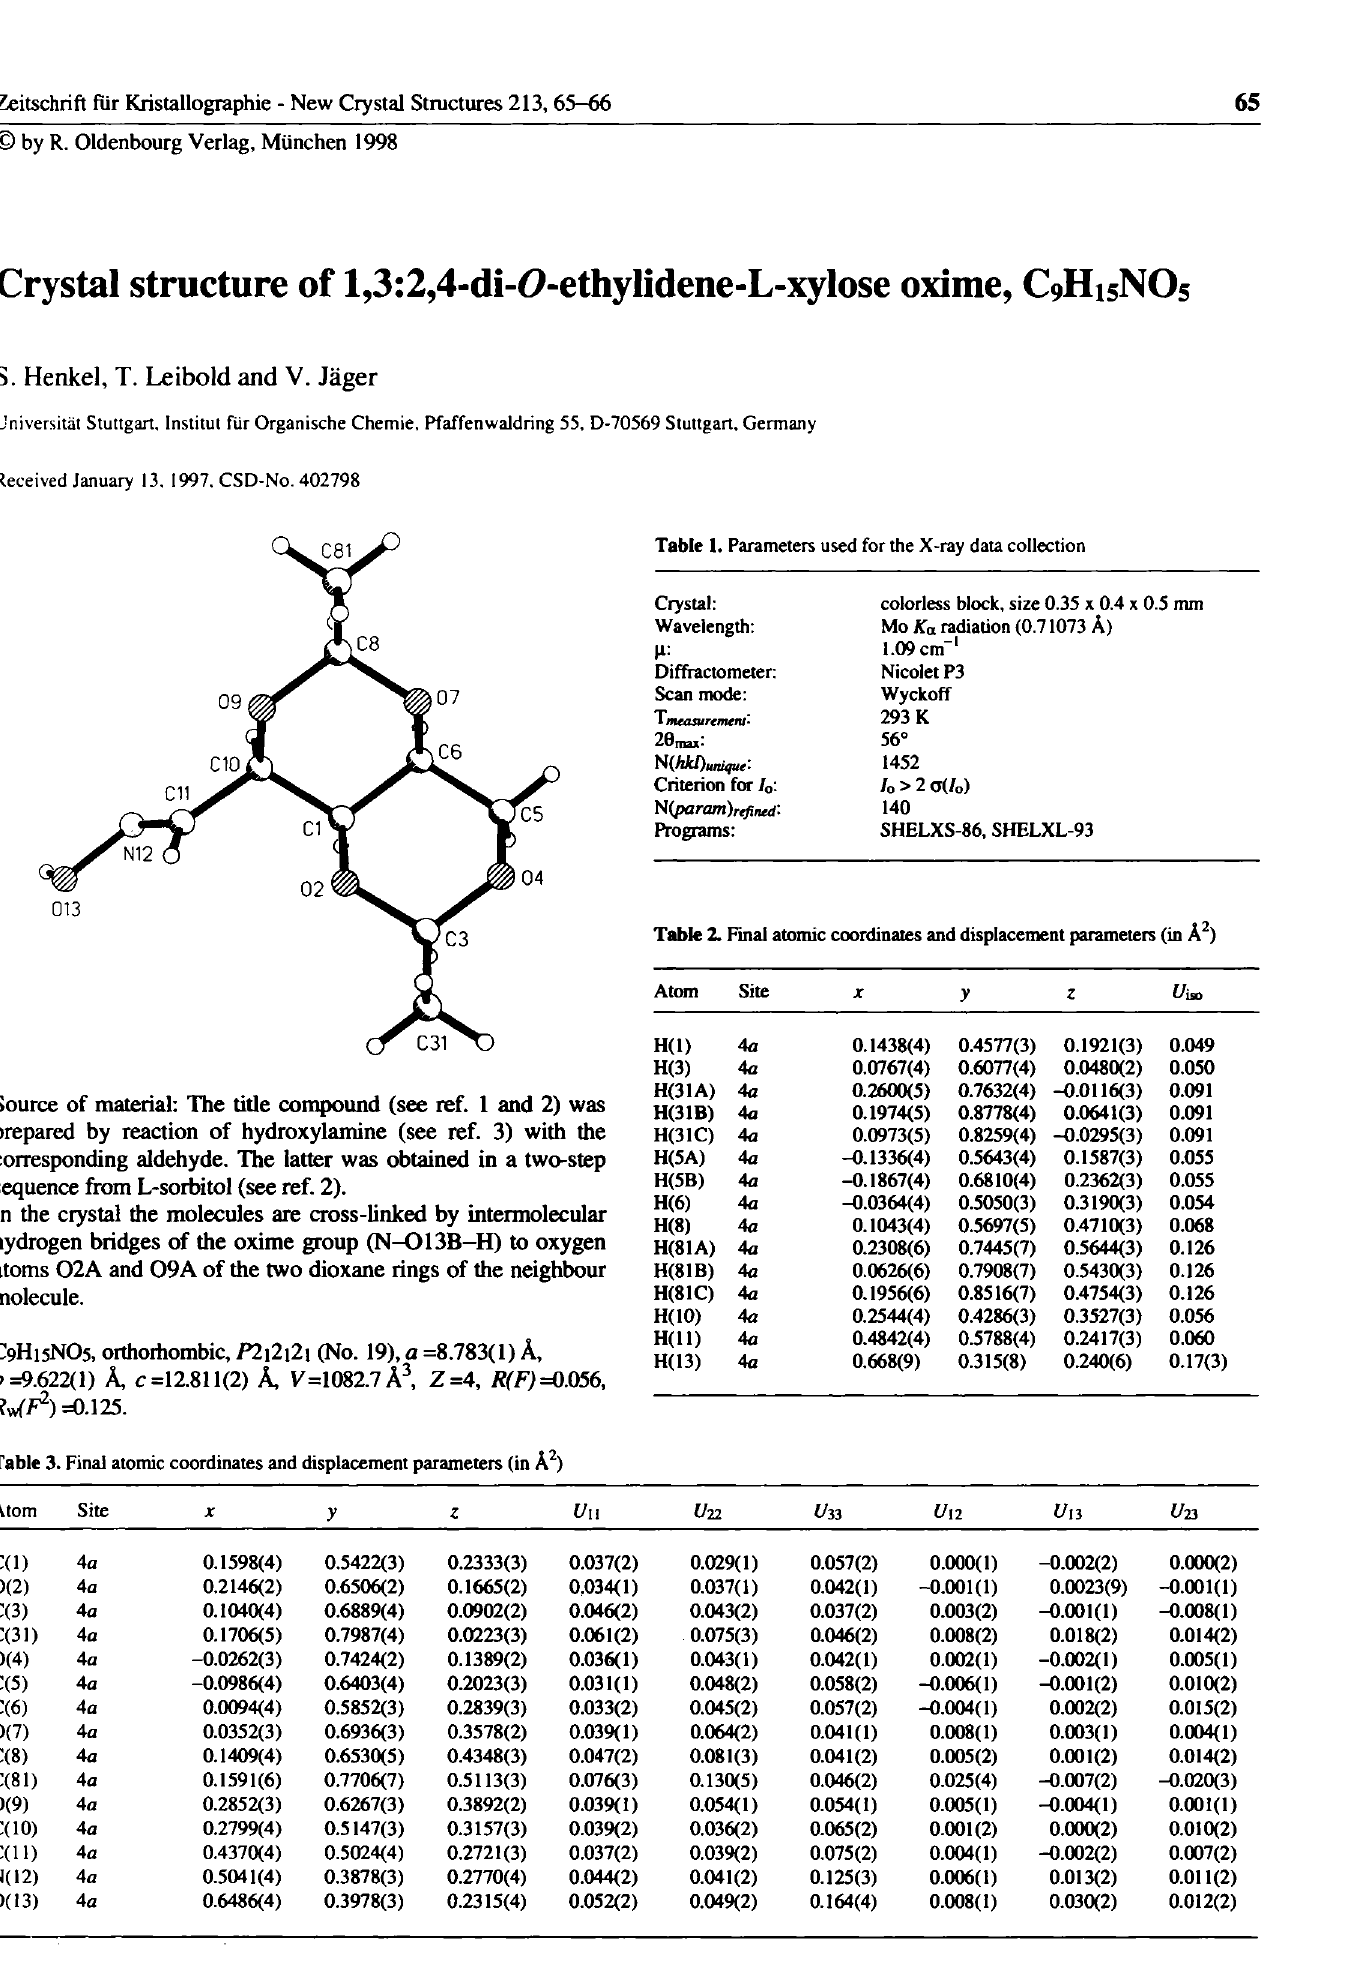
Table 1. Parameters used for the X-ray data collection